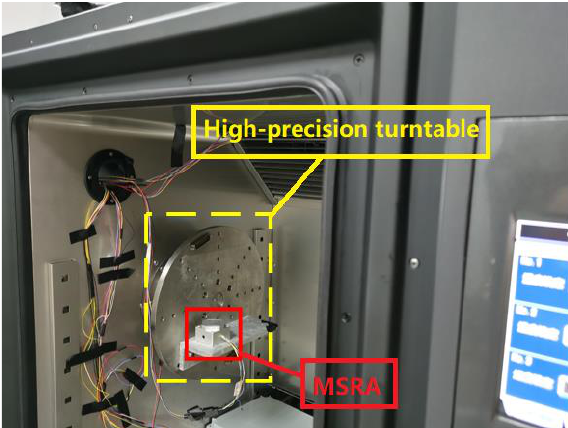
Figure 6. Temperature experimental